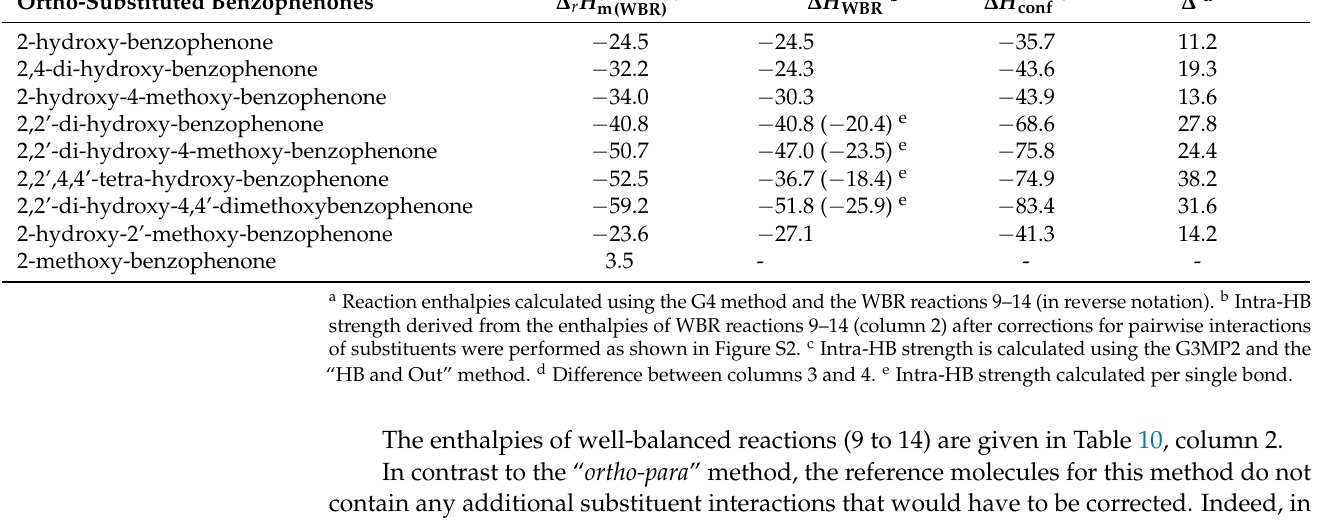
Figure 11. Determination of the intra-molecular hydrogen bonding strength in 2-hydroxy-benzophenone using the “ well-balanced reaction ” method. The reaction enthalpy ∆ r H o m(WBR) = − 24.5 kJ · mol − 1 (see Table 10, column 2). The intra-HB-strength ∆ H WBR = − 24.5 kJ · mol − 1 (see Table 10, column 3). The enthalpies of well ‐ balanced reactions (9 to 14) are given in Table 10, column 2. Table 10. Strength of intra-molecular hydrogen bonding (intra-HB) in ortho-substituted benzophe- nones at T = 298.15 K ( p ◦ = 0.1 MPa, in kJ · mol − 1 ).